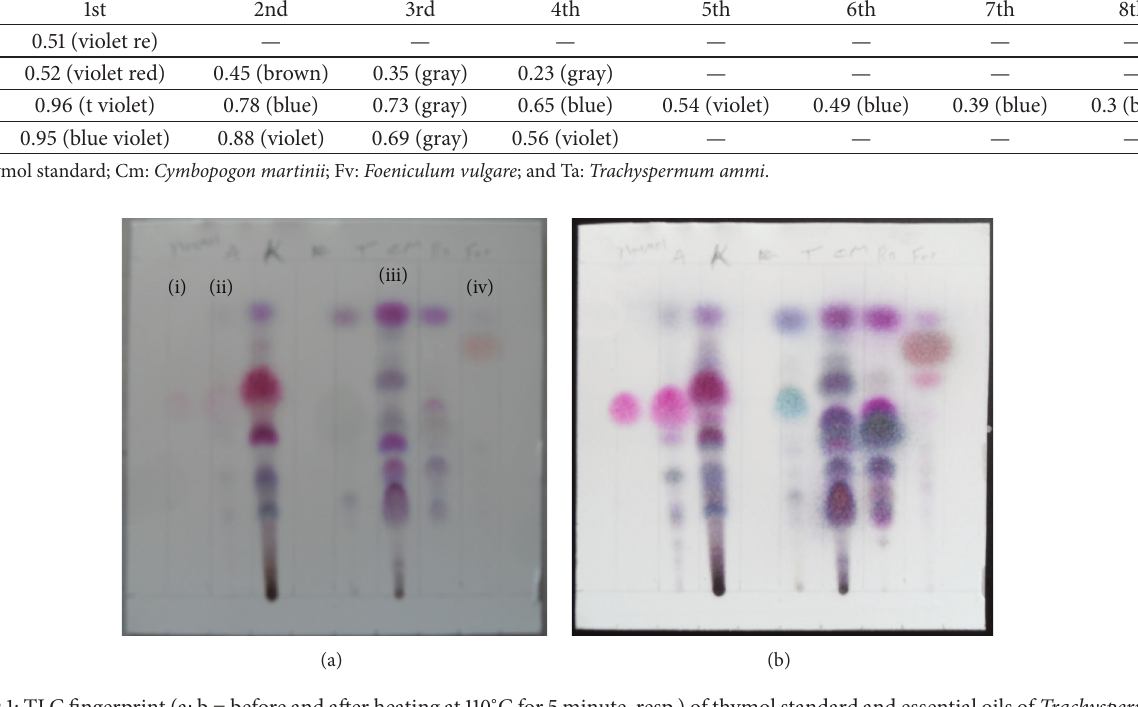
Figure 1: TLC fingerprint (a; b = before and after heating at 110 ∘ C for 5 minute, resp.) of thymol standard and essential oils of Trachyspermum